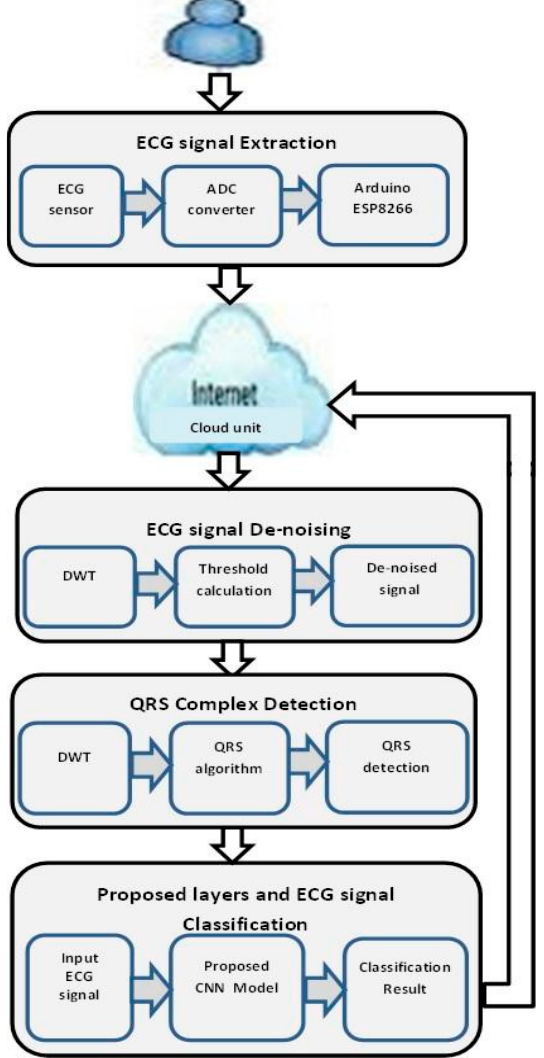
Figure 17. Proposed novel ECG signal registration and classification system [97].